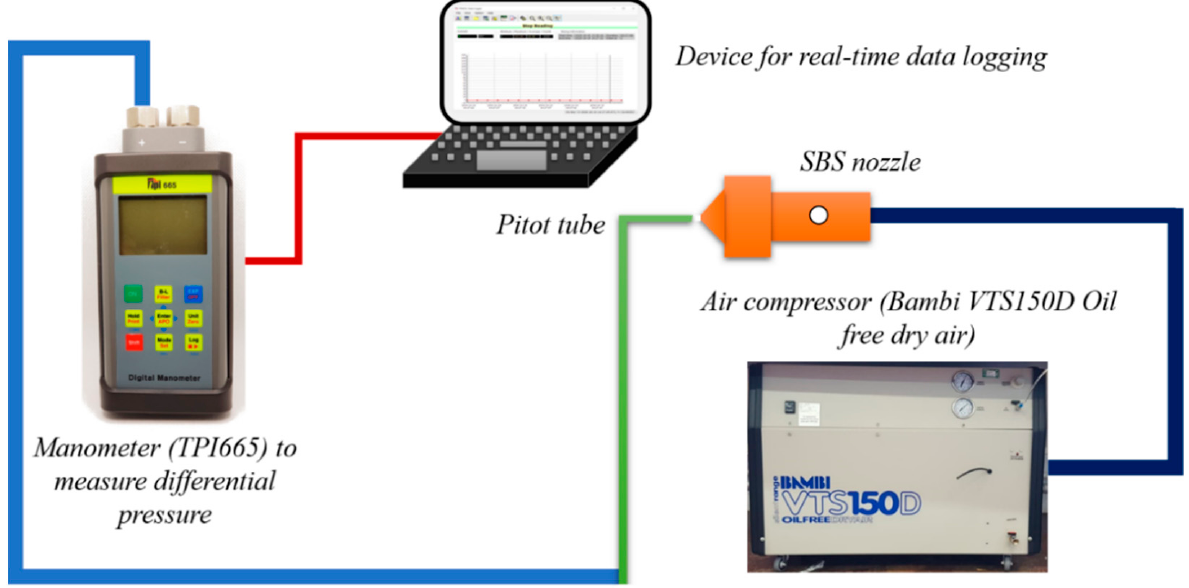
Figure 1. A schematic diagram showing the setup to measure the airflow field as it exists the SBS nozzle.